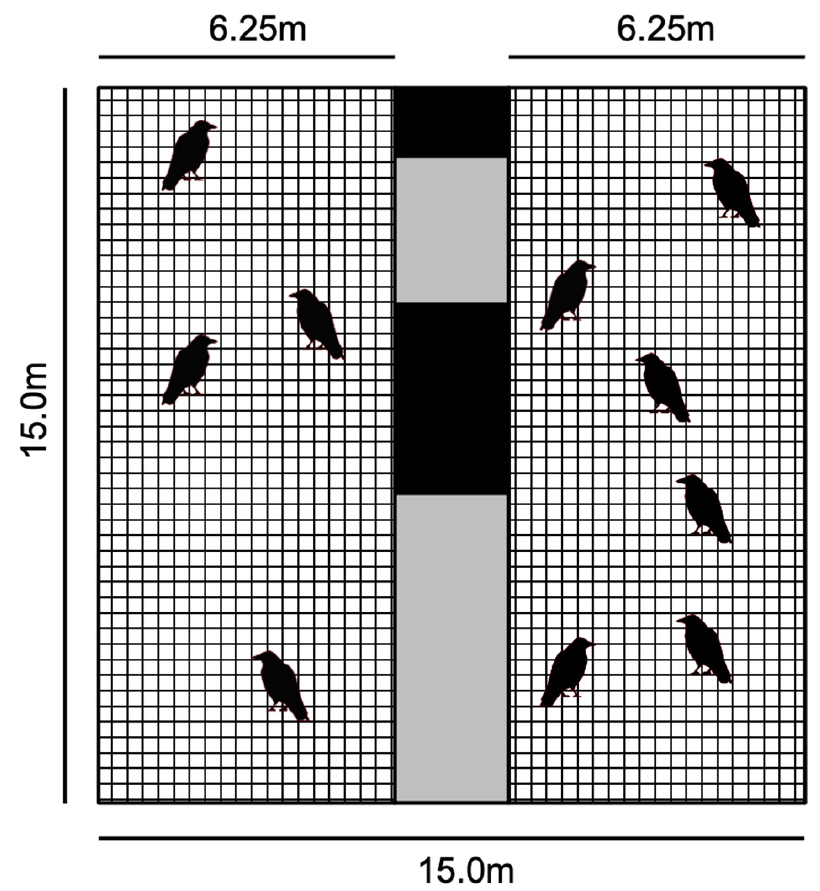
Figure 1. Schematic of the wire-mesh testing enclosures for both groups of birds. Black areas depict opaque barriers within the 2.5 m of separation between groups during testing.